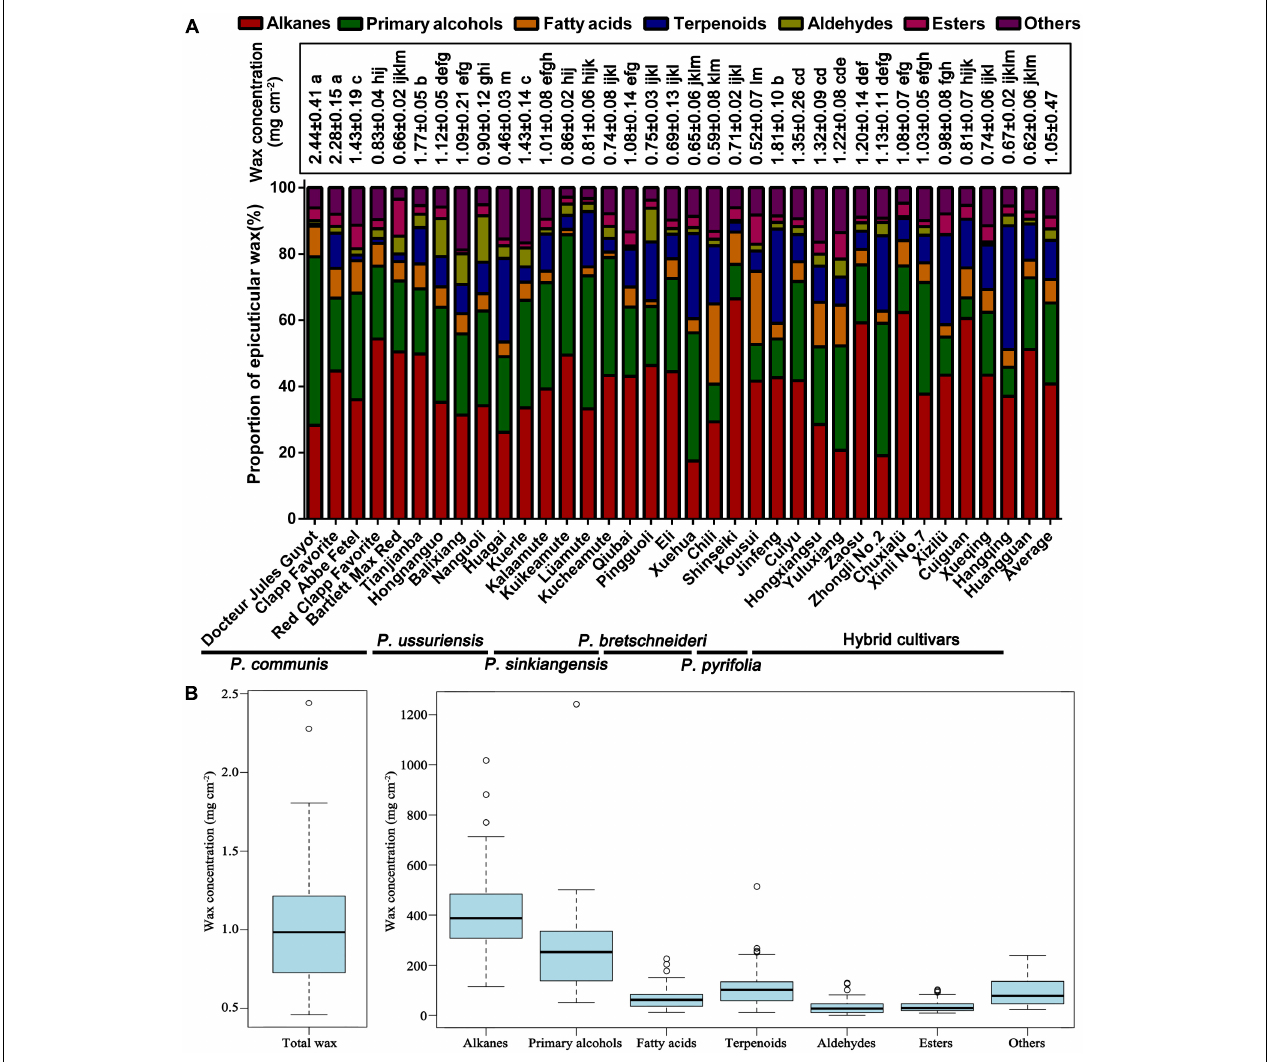
FIGURE 1 | Amounts and compositions of epicuticular wax in the mature fruits of 35 pear cultivars. (A) Total epicuticular wax concentration and relative wax compositions of the mature fruits of 35 pear cultivars. Statistical significance was determined using Student’s t -test. Each value is the mean ± SD of three biological repeats. Different letters above each bar indicate significant differences at the 5% level. (B) Range and distribution of total wax and seven wax compounds in 35 pear cultivars. The horizontal lines in the interior of the box are the median values. The height of the box is equal to the interquartile distance, indicating the distribution for 50% of the data. Approximately 99% of cultivars fall inside the whiskers, and the cultivars outside these whiskers are considered outliers or extreme values, indicated by horizontal lines and